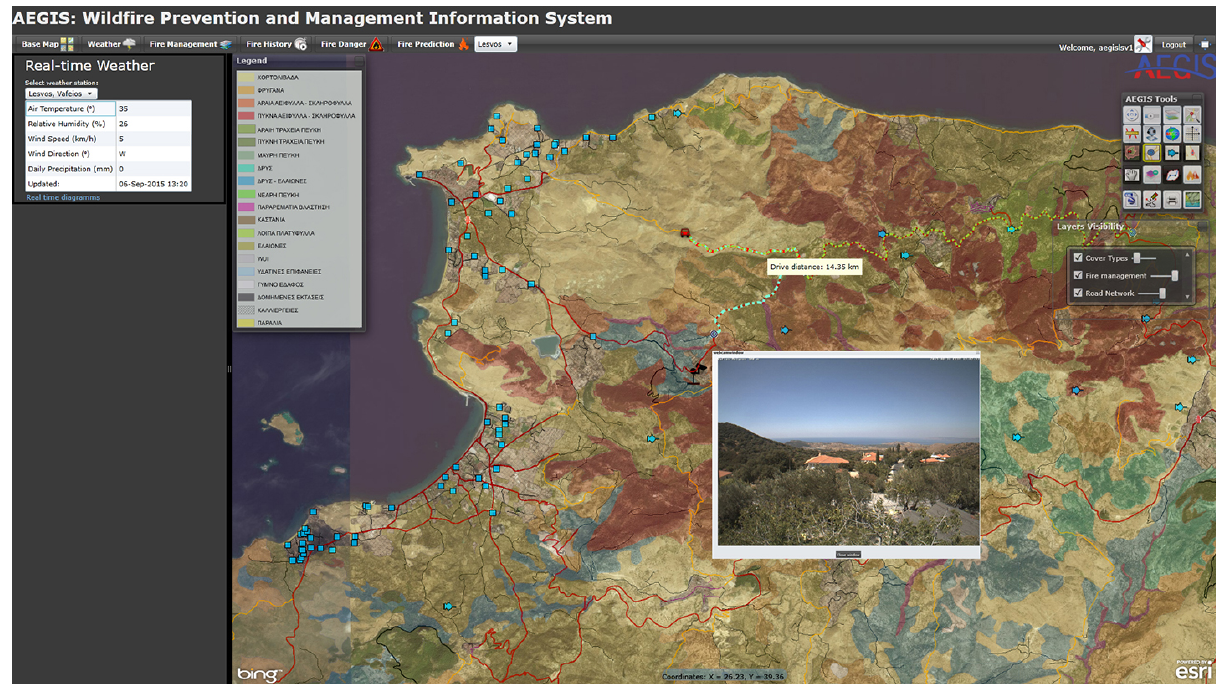
Figure 6. Optical camera surveillance combined with visualization of the road network, the pumping stations, the cover types and real-time weather records from the closest RAWS within the AEGIS graphical interface. Table 3. Live herbaceous and live woody moisture values (%) used for wildfire